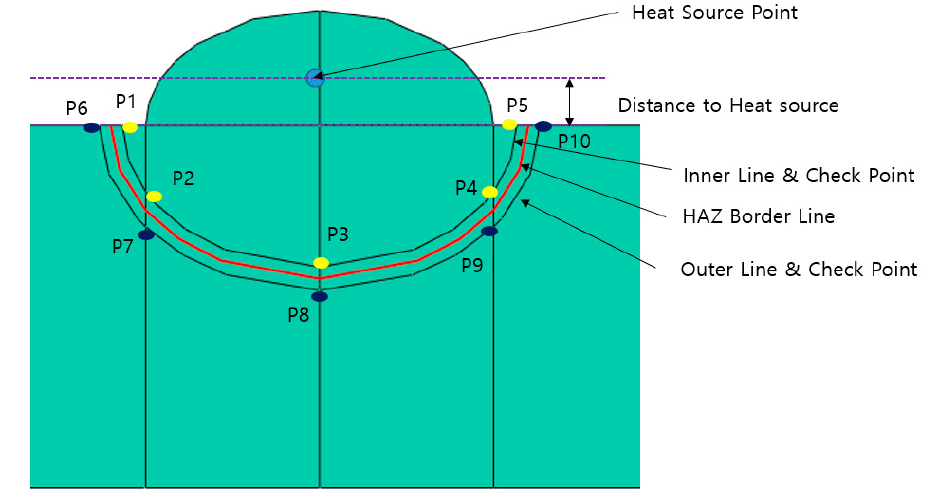
Figure 11. HAZ border line and temperature check line.